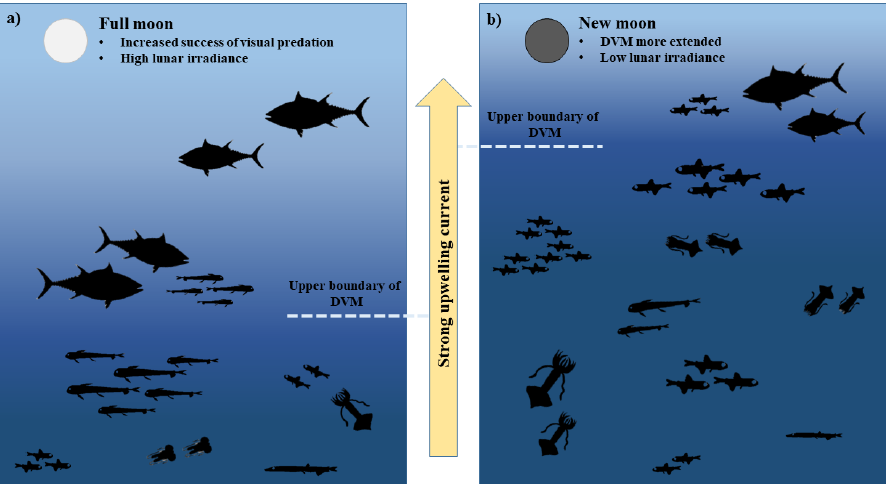
Figure 8. Schematic representation of BFT predation on mesopelagic resources in the Strait of Messina during full moon and new moon. In both lunar phases, the strong currents foster upwelling phenomena and, then, passive transport of mesopelagic food resources. On one hand, during full moon the high lunar irradiance increases the success of BFT visual predation ( a ). On the other hand, during the new moon the vertical movements of mesopelagic resources are larger and reach shallower water layers, making food more readily available for BFT ( b ).